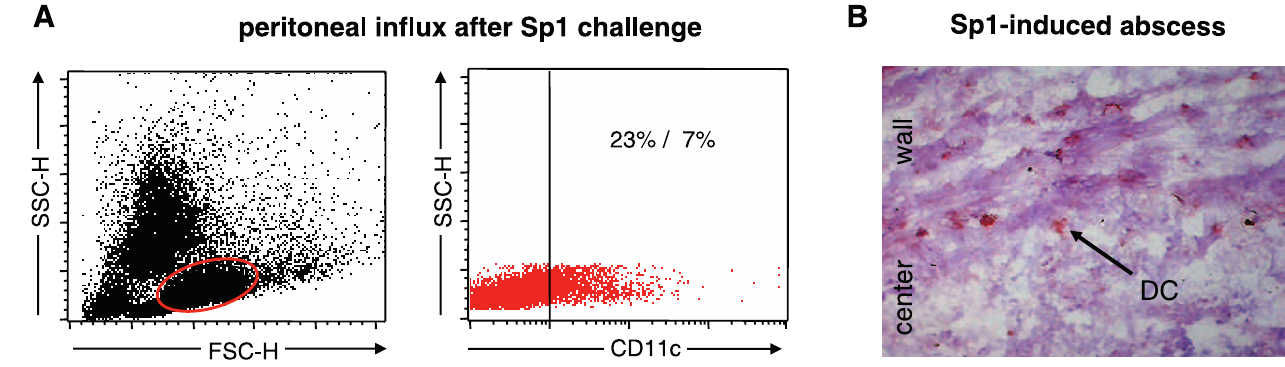
Figure 1. DCs in Intraabdominal Abscess Formation Induced by Sp1 (A) Twenty-four hours after intraperitoneal Sp1 challenge, cells of the peritoneal influx were stained with phycoerythrin (PE)–conjugated anti-CD11c mAb to stain DCs, and analyzed by flow cytometry. Numbers in the right quadrant of the right dot blot represent the percentage of CD11c-positive cells gated as indicated in the left dot blot and non-gated cells, respectively. FSC-H, forward scatter; SSC-H, sideward scatter. (B) Immunohistology of abscesses was performed with anti-CD11c mAb. One single CD11c-positive cell in the abscess wall is labeled with a black